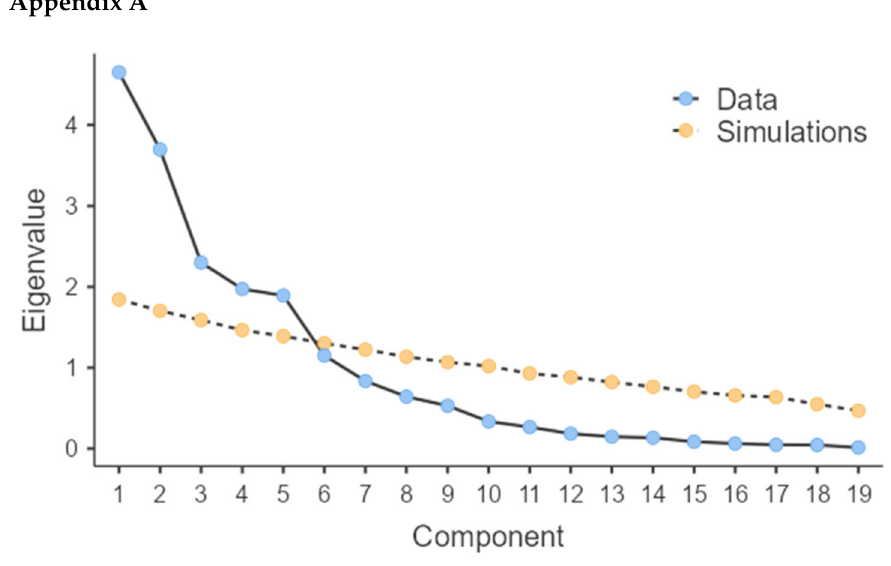
Figure A1. The scree